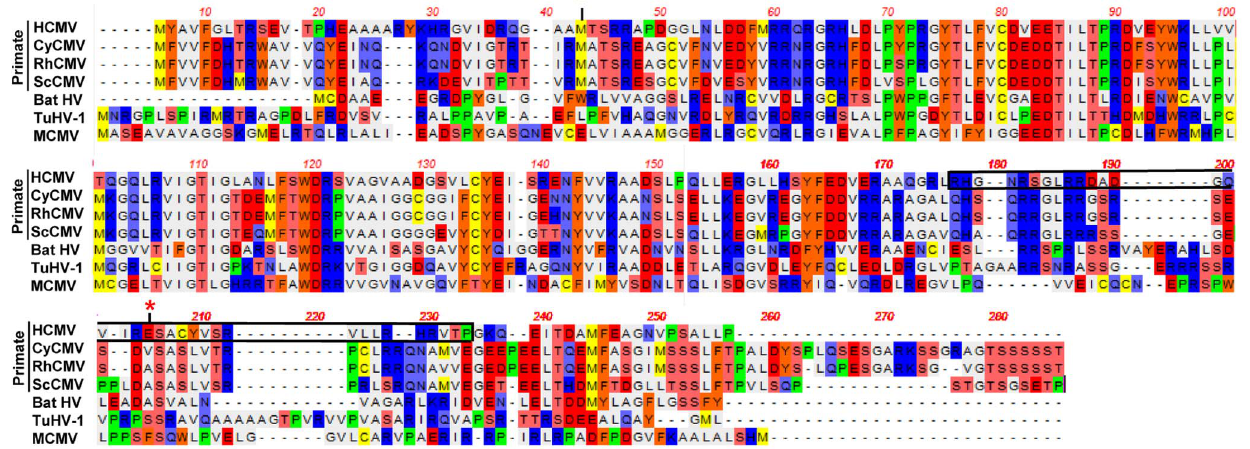
Figure 8. Comparison of U L 26 protein sequences of various species-specific cytomegaloviruses. The U L 26 open reading frames of the indicated CMV species were aligned using the NCBI BLAST alignment tool. The black box highlights a putative NLS as predicted by the NLS mapper. The green asterisk indicates the 2 nd initiation methionine and the red asterisk indicates the # 185-stop insertion site.